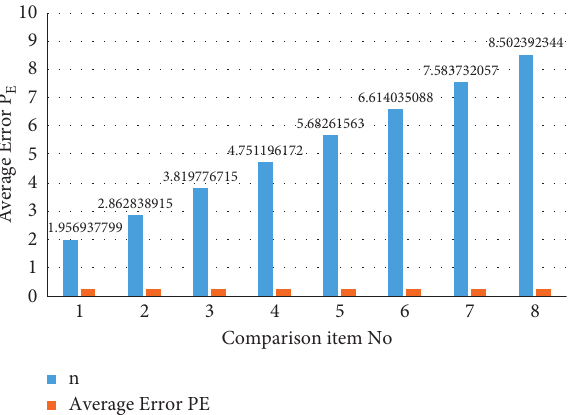
Figure 6: The influence of different values of filter size n on al- gorithm security.